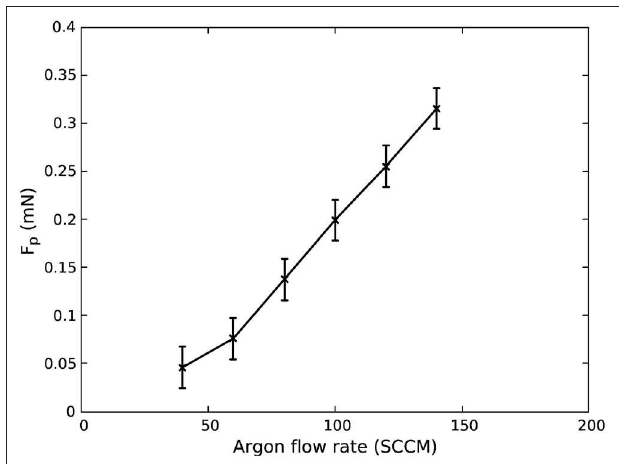
FIGURE 10 | Plasma thrust F p vs. flow rate for fixed 30 W RF power. The reported thrust in this plot is the thrust due to the RF and does not include the cold gas